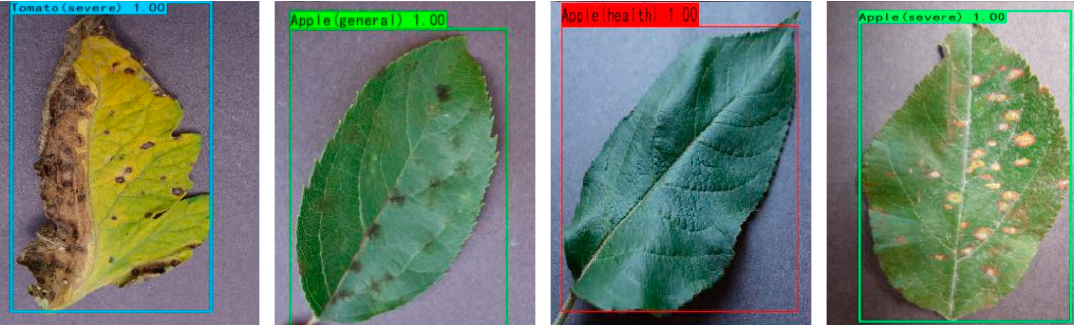
Figure 16. DBA_SSD recognition effect.